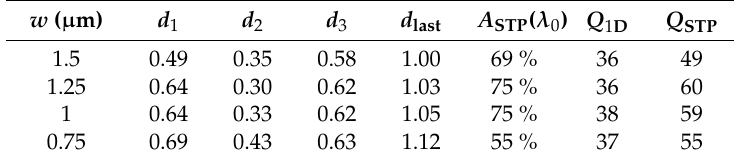
Table 1. Widths, relative absorption, and quality factors for the obtained GA optimized configurations using 1D TP structures and four dielectric layers with a target resonance wavelength λ 0 = 4.26 µ m. They differ in the target inclination angle θ β corresponding to different slab thicknesses in the waveguide-scenario.